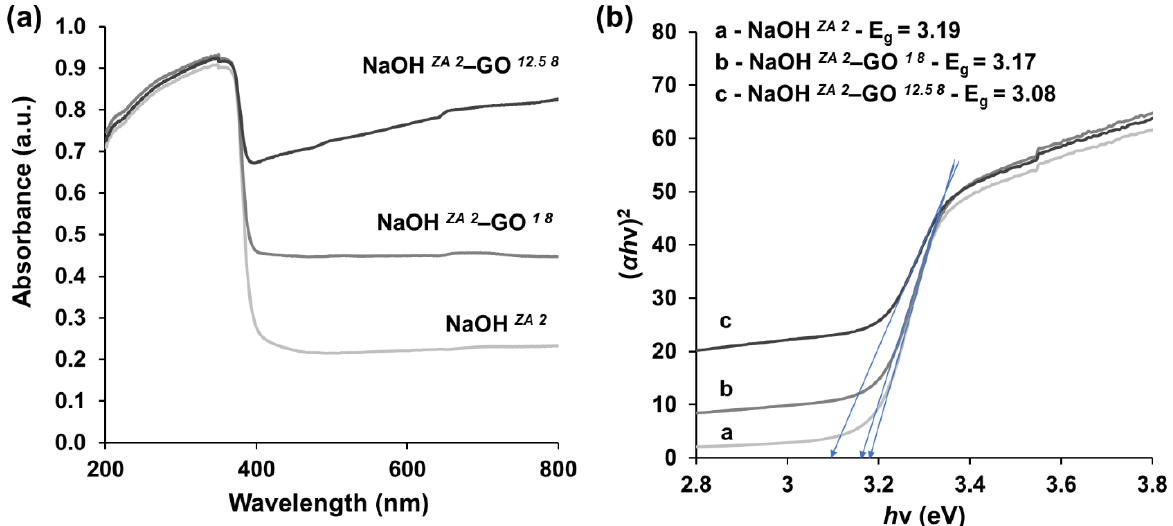
Figure 6. ( a ) UV-vis diffuse reflectance (DRS) and ( b ) Tauc plots of ZnO (NaOH ZA 2 ) and ZnO – rGO composites with the addition of different GO concentration: 1 mg/mL (NaOH ZA 2 – GO 1 8 ) and 12.5 mg/mL (NaOH ZA 2 – GO 12.5 8 ).